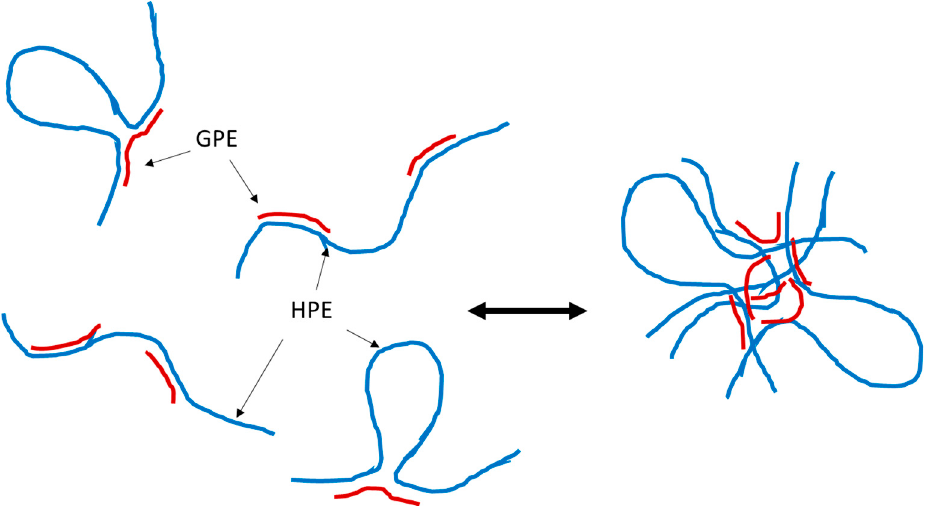
Scheme 1. Non-stoichiometric interpolyelectrolyte complexes.